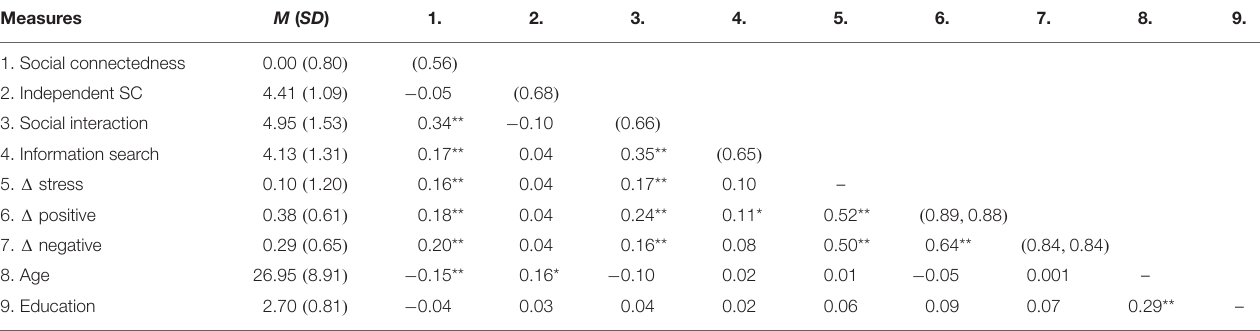
TABLE 1 | Intercorrelations for Measures Included in Study 1 ( n = 331). Measures